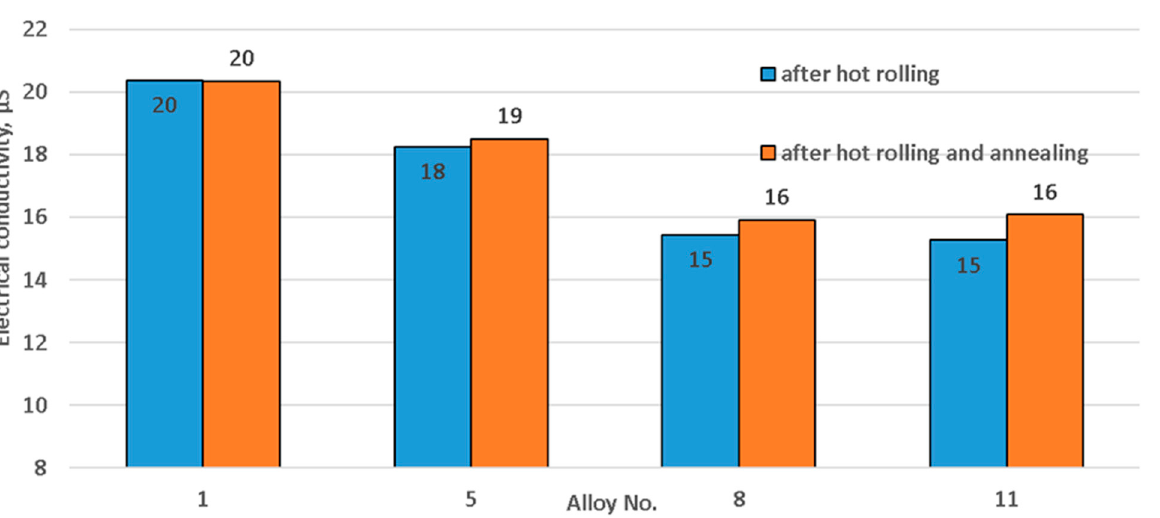
Figure 5. Change of electrical conductivity related to alloy chemical composition.